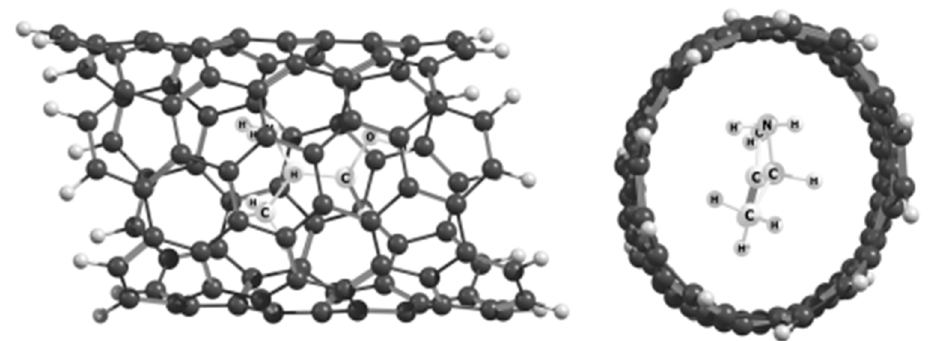
Figure 19. The most stable endocomplex, S-C 3 H 7 NO 2 @P(5,2). Adapted with modification [259]. Table 4. Relative energies of SWCNTs, α -alanine and clusters of α -alanine together with the electric charge of the guest molecule (PBE/3 ζ ) [259]. Object Δ G 2980 ( Δ G 298 ≠ ), kcal/mol